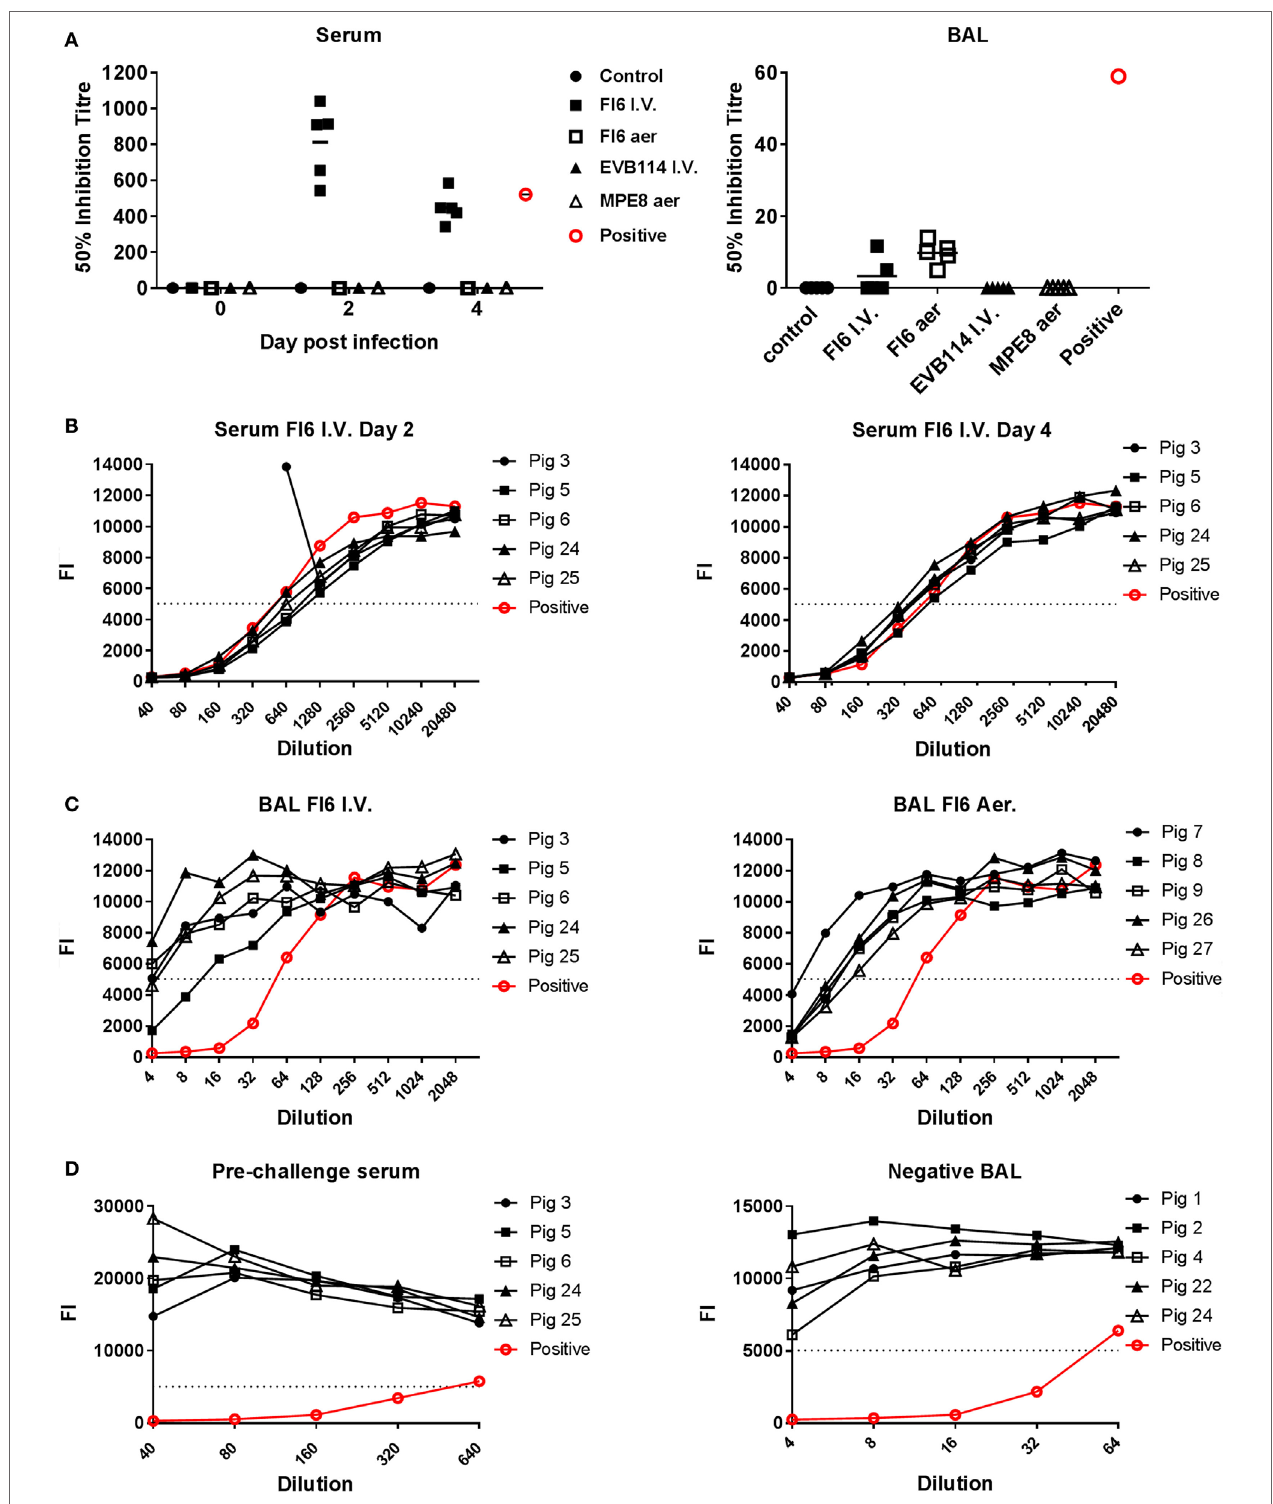
FigUre 4 | Entry neutralization activity of serum and broncho-alveolar lavage (BAL) following administration of antibodies. (a) Individual 50% inhibition titers in the serum at 0, 2, and 4 day post infection (dpi) and BAL at 4 dpi. (B) Neutralizing antibody response measured in the serum of the pigs following FI6 I.V. administration at 2 and 4 dpi. (c) Antibody response in the BAL of animals given FI6 I.V. or by aerosol at 4 dpi. (D) Negative sera from pre-challenge samples and negative BAL from control animals are shown alongside positive control. The dashed line represents the 50% inhibition titer and FI the fluorescence intensity of green-fluorescent protein. The neutralizing titer of serum and BAL from animals infected with the same A/sw/Eng/1353/09 virus and sacrificed at 14 dpi is shown in red.